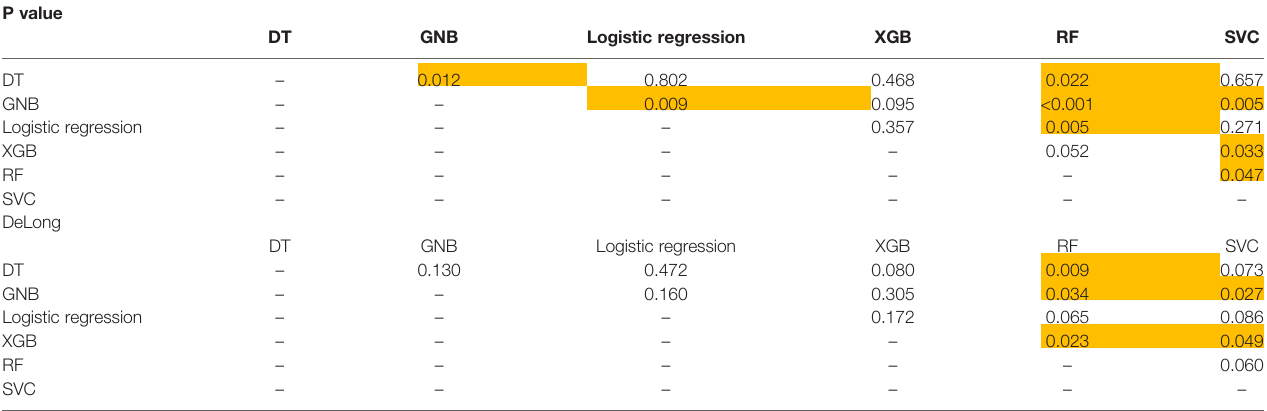
TABLE 4 | P value and DeLong test of each classi fi er on the sequence-combined model based on patients for predicting PCa. P